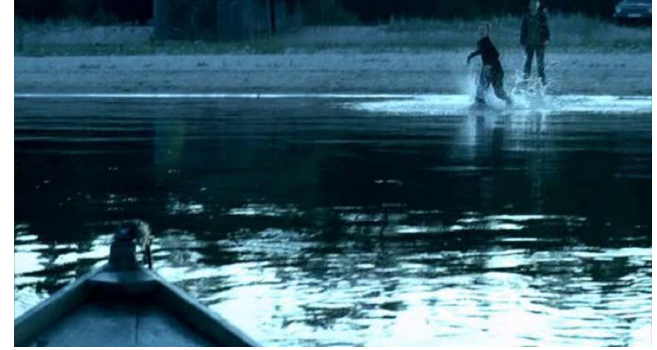
Figure 8. The Return